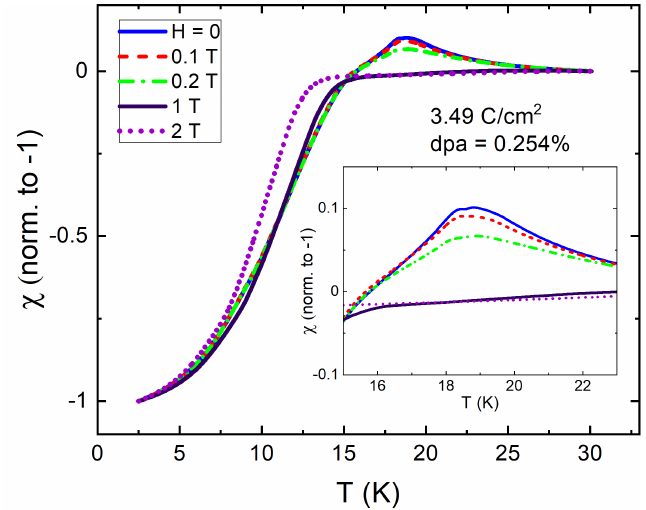
Figure 6. The magnetic-field dependence of TDR dynamic magnetic susceptibility in a 3.49 C/cm 2 electron irradiated sample. The indicated magnetic fields were applied parallel to c-axis. The inset zooms on the transition region.